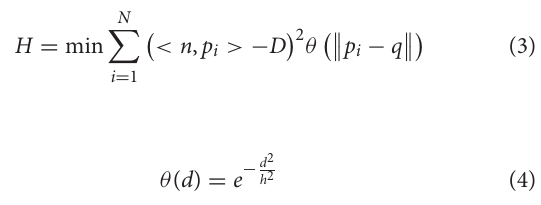
normal vector n to smooth the whole grape point cloud model, as shown in Figure 7C